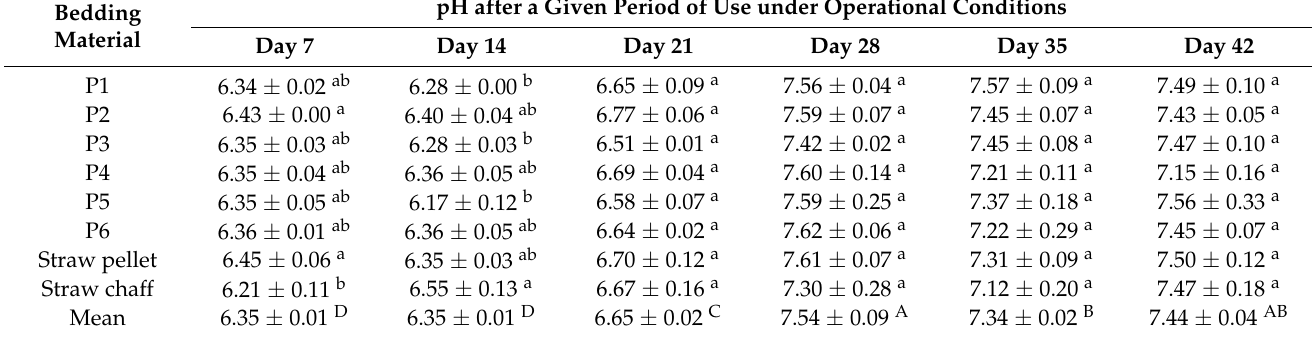
Table 4. Changes in the pH of bedding materials during their exploitation—2nd experimental